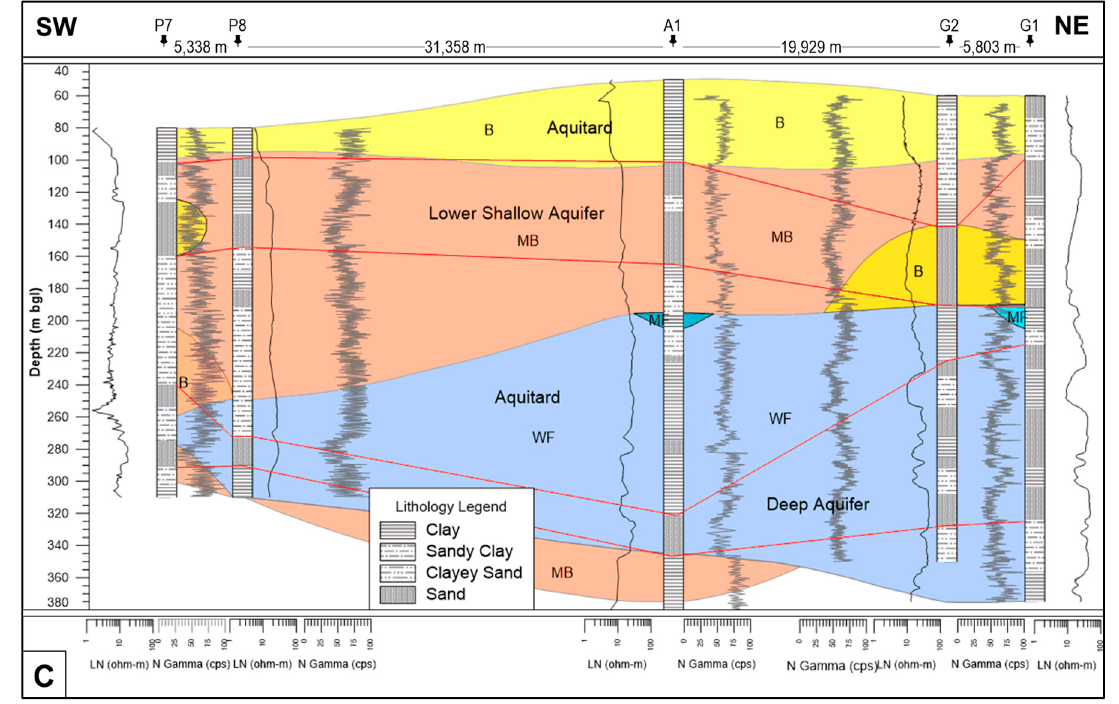
Figure 4. The cross-sections based on the natural gamma and LN resistivity logs. ( A ) cross-section along the line P6/P4/P3/P1/P5; ( B ) cross-section along the line K1/A1/P4; ( C ) cross-section along the line P7/P8/A1/G2/G1. In each cross-section, the water quality is shown by different colors (MF = blue, WF = light blue, B = light yellow, and MB = peach puff). The location of the cross-section lines is shown in Figure 1.